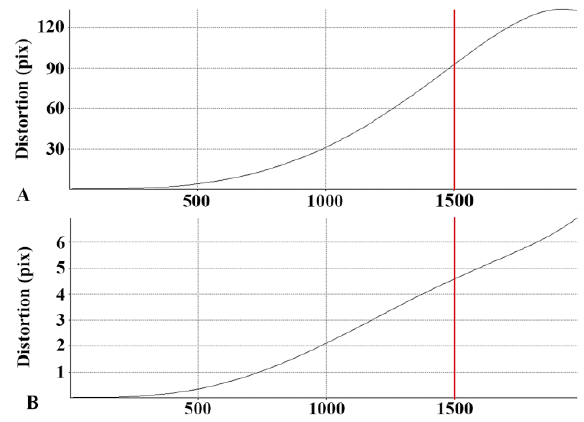
Figure 4. The sketches of the distortions: A) before B) after build-up Lense Distortion Corrections (LDC). Vertical red line - the half of the sensor